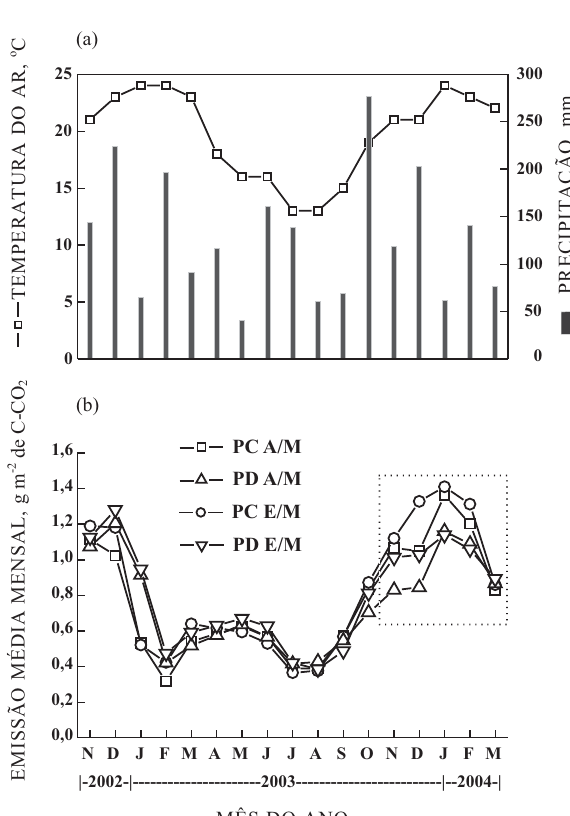
Figura 1. Médias mensais da temperatura do ar, da precipitação pluviométrica (a) e da emissão de do solo (b) nas combinações de sistemas C-CO 2 representa o período logo após o manejo